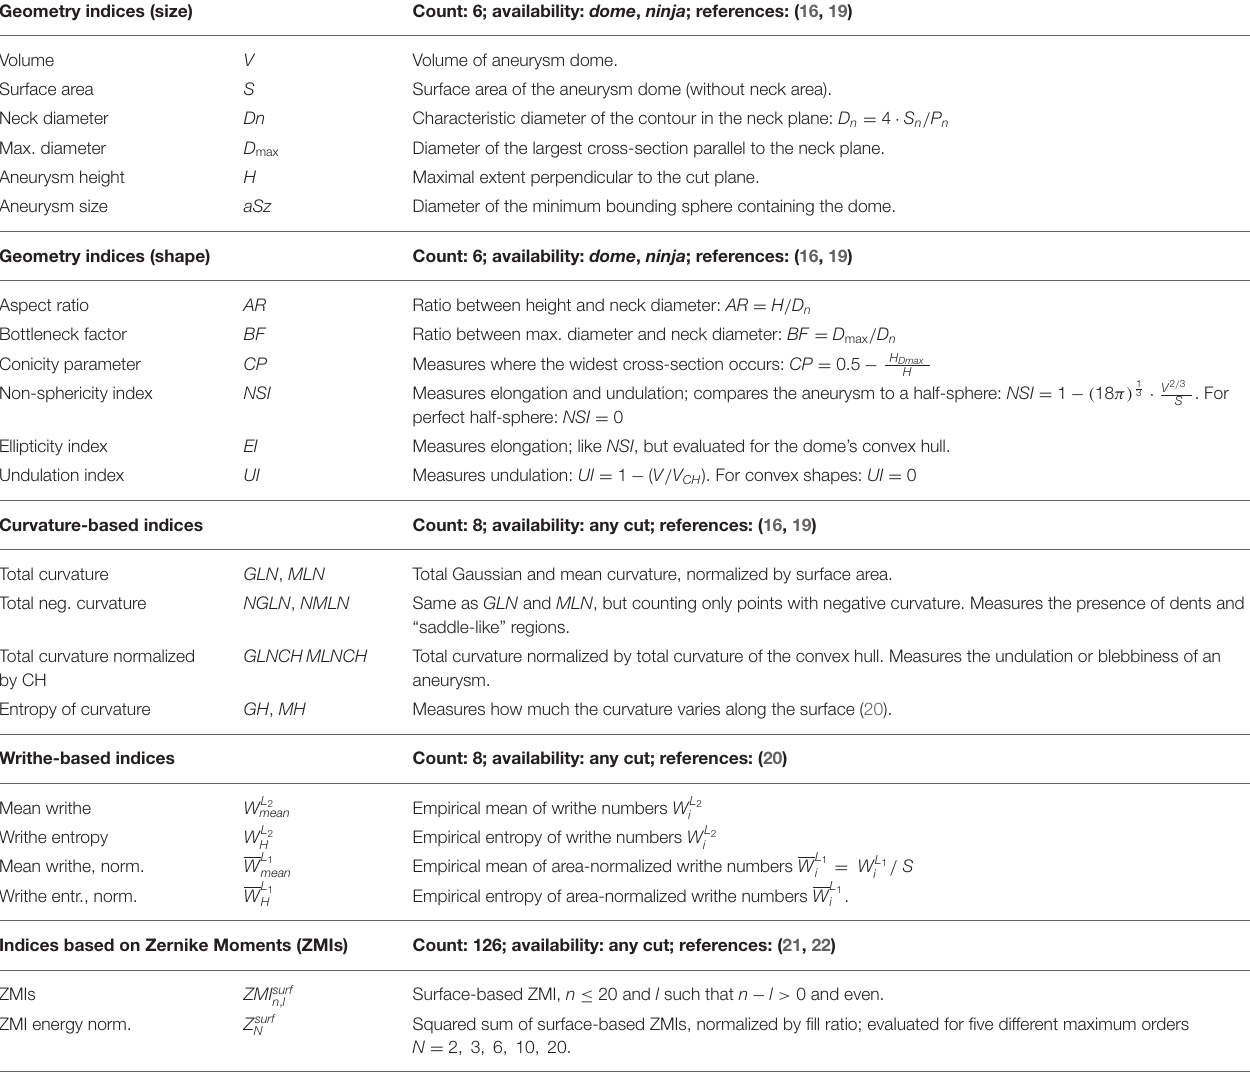
TABLE 1 | Overview of the shape features considered in this study. Geometry indices